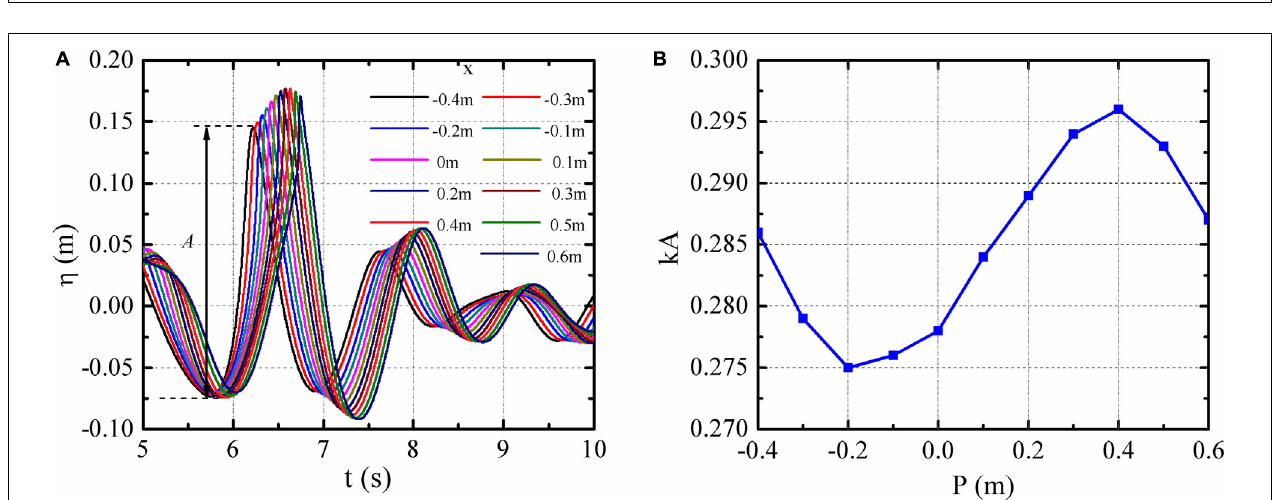
FIGURE 5 | Wave elevation histories and wave front steepness kA at different locations. (A) Wave elevation histories, (B) wave front steepness kA at different locations.